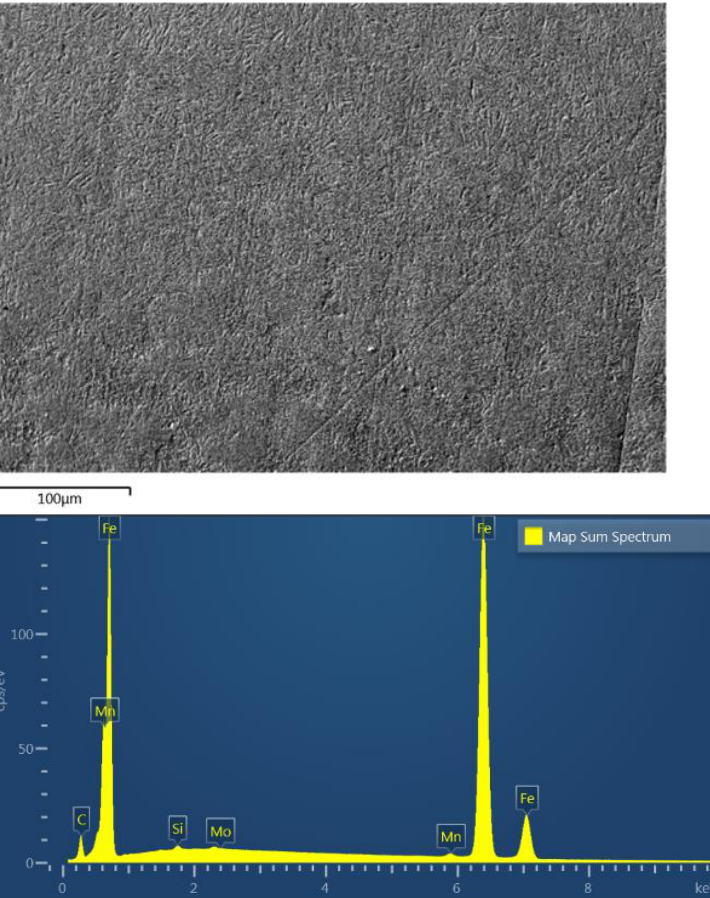
Figure 14. EDS spectrum registered in the HAZ of a sample cladded at 2400 W laser power at a position close to the interface (HAZ1 + HAZ2 subareas -upper photo).